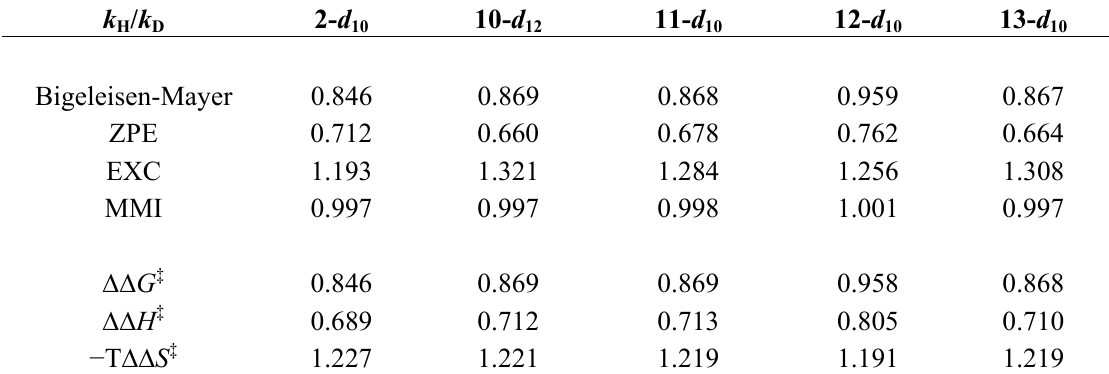
Table 4. Computed CKIEs for compounds 2 and 10 – 13 using scaled B3LYP/6-31G(d,p) harmonic frequencies (315 K) via the Bigeleisen-Mayer or  H  S